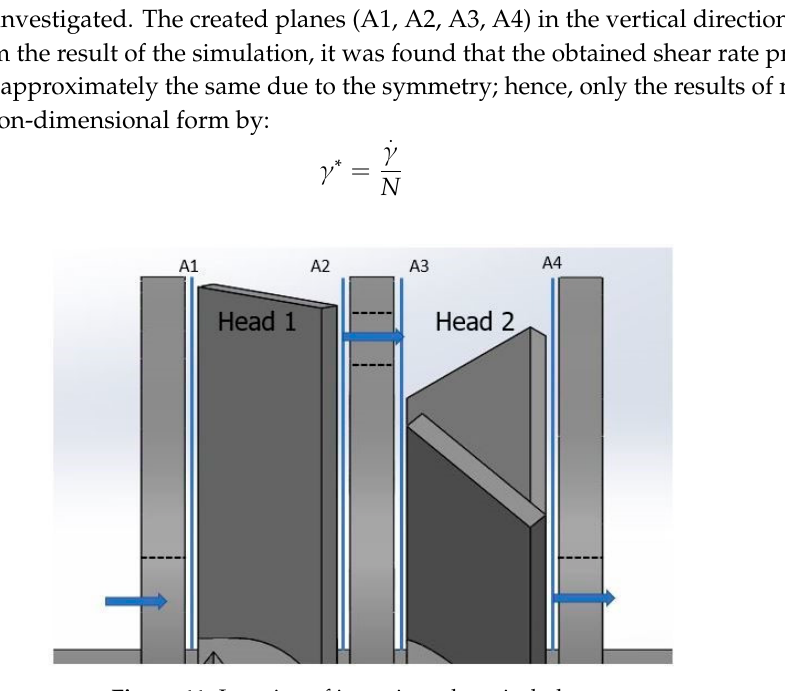
Figure 11. Location of investigated vertical